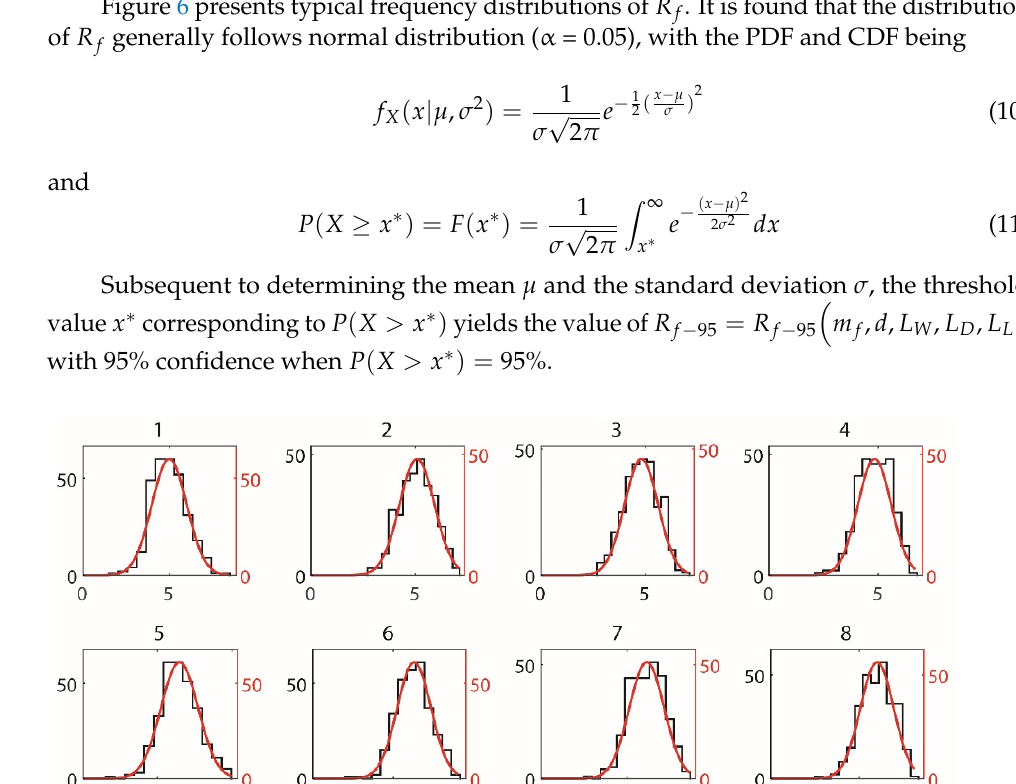
− y − z and A y . Figure 5. Characteristics of a crack related to the calculation of crack fill ratio. ( a ) View of crack crack crack